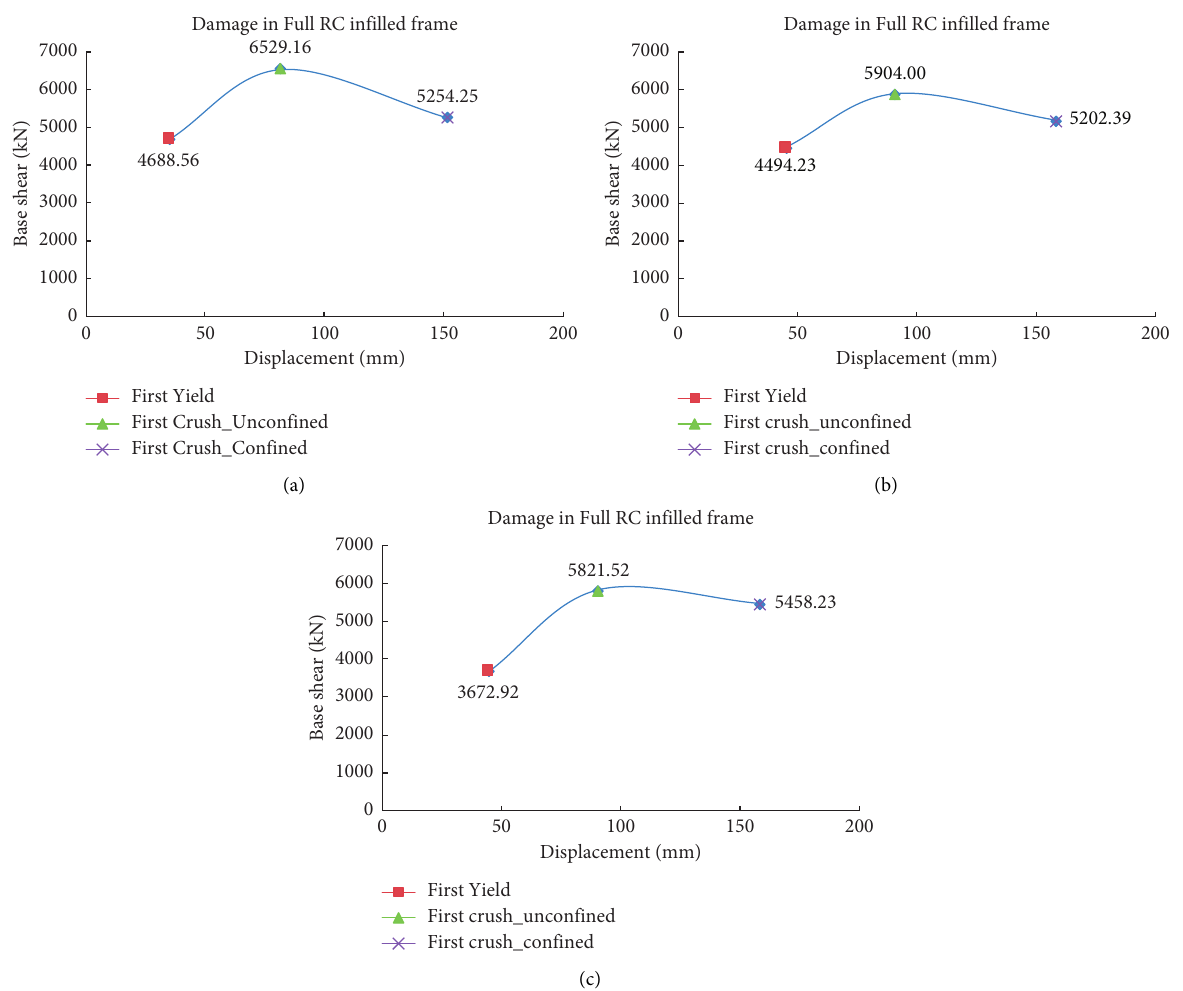
Figure 14: Damage pattern of the full RC infilled frame for different values of the compressive strength of infill: (a) 5MPa; (b) 4MPa; (c)